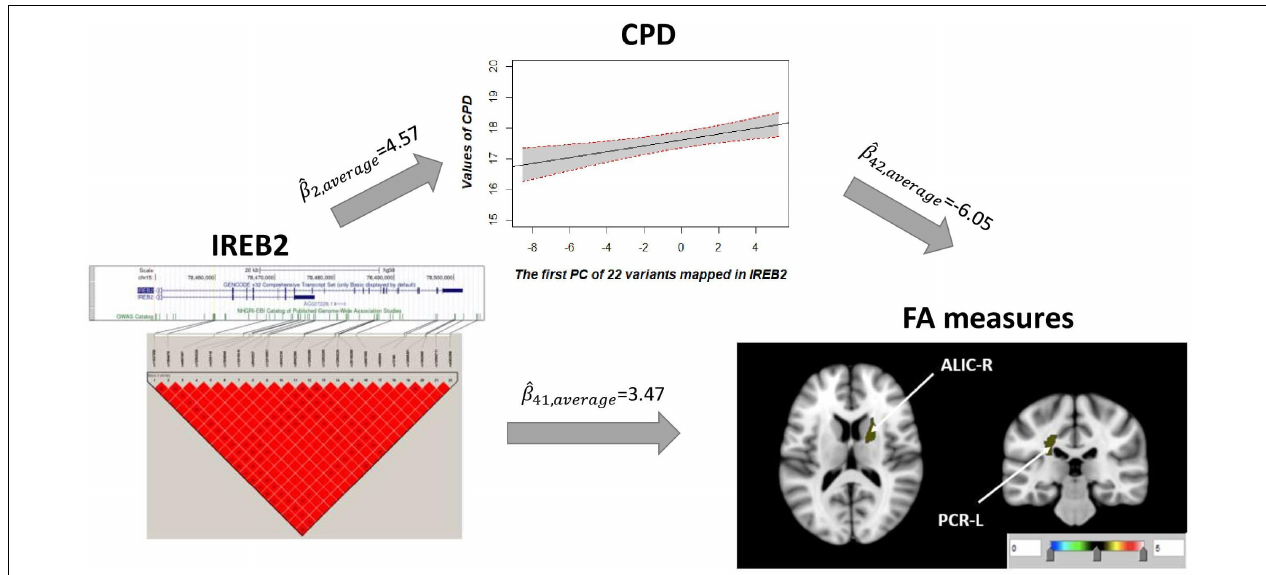
FIGURE 4 | CPD mediates the genetic effects of 22 variants located within IREB2 (chr15: 78,459,619–78,503,762) on two regional FA measures (ALIC-R and PCR-L). Exact locations of the 22 variants on the genome and their pairwise LD scores are shown. Due to the strong LD relationship among the variants, CPD was regressed on the first PC of 22 variants to describe the association of CPD vs. genetics. Colors in the brain images denote the average –log10( p -value) of FA association with the 22 variants. The direct ( ˆ β 41 ) and indirect effects ( ˆ β 2 ˆ β 42 ) are averaged over all SNPs and FA measures. CPD, cigarette per day; FA, fractional anisotropy; ALIC-R, right tract of the anterior limb of the internal capsule; PCR-L, left posterior corona radiata; LD, linkage disequilibrium; SNPs, single-nucleotide